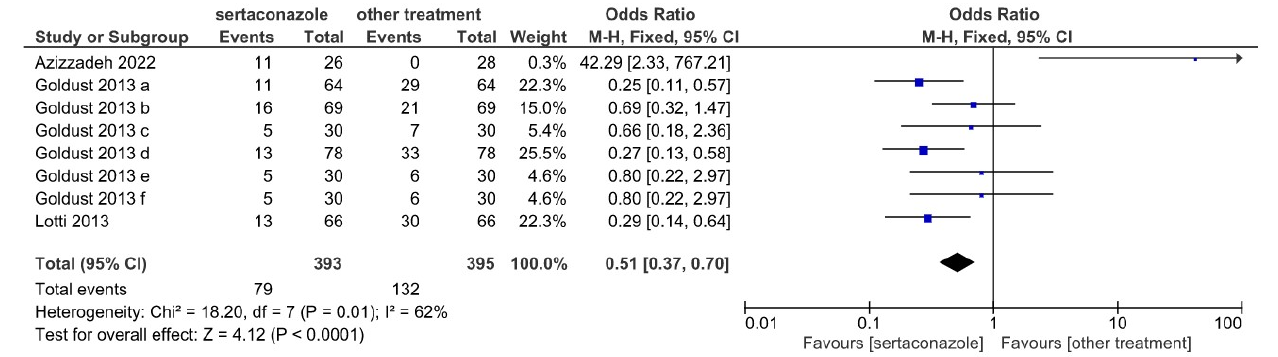
Figure 4. Forrest plot illustrating the effect of sertaconazole vs. other treatments in the eight selected studies for the moderate and severe SI at 28 days of treatment (OR with 95% confidence interval, heterogeneity, and overall effect).